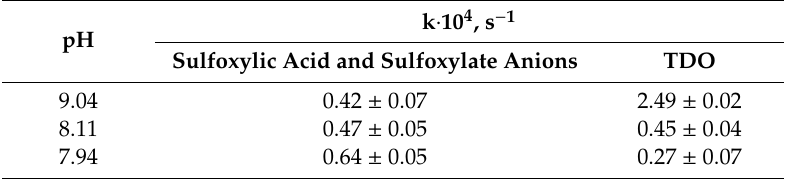
Table 1. Rate constants for decomposition of thiourea dioxide (TDO), sulfoxylic acid, and sulfoxylate anions as a function of